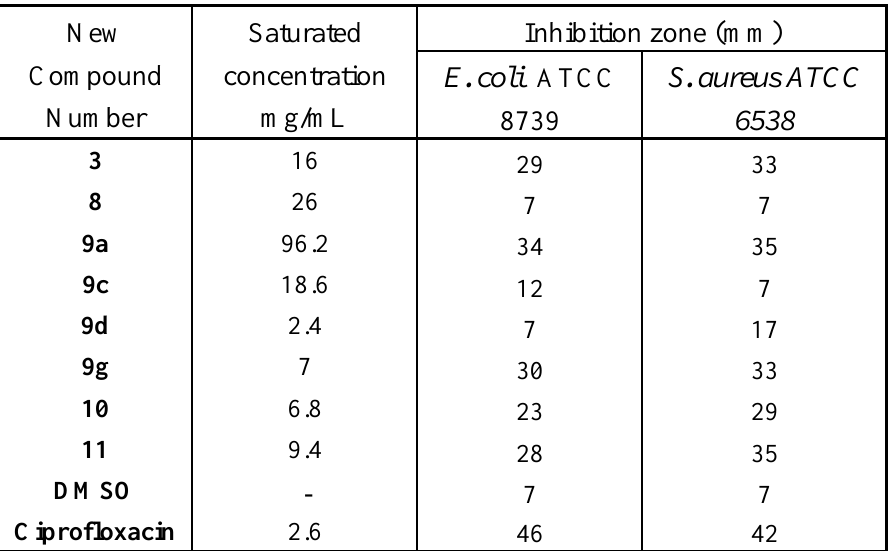
Note: diameter of wells = 7 mm